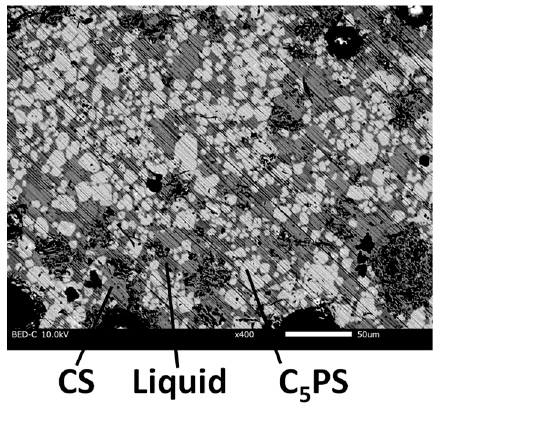
Figure 6. SEM image of M3-A2 (2mass% Al 2 O 3 ) ( left ) and phase composition projected on an iso- thermal section of the CaO-SiO 2 -P 2 O 5 ternary phase diagram at 1573 K ( right ).